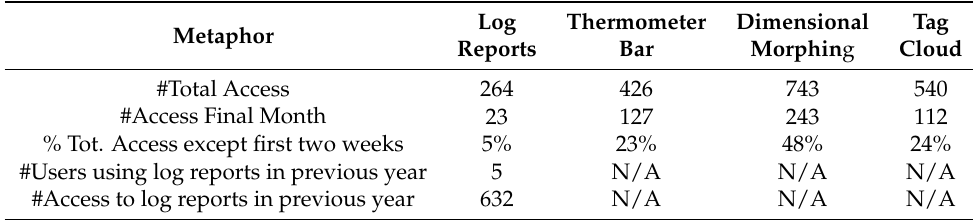
Table 1. Quantitative assessment.